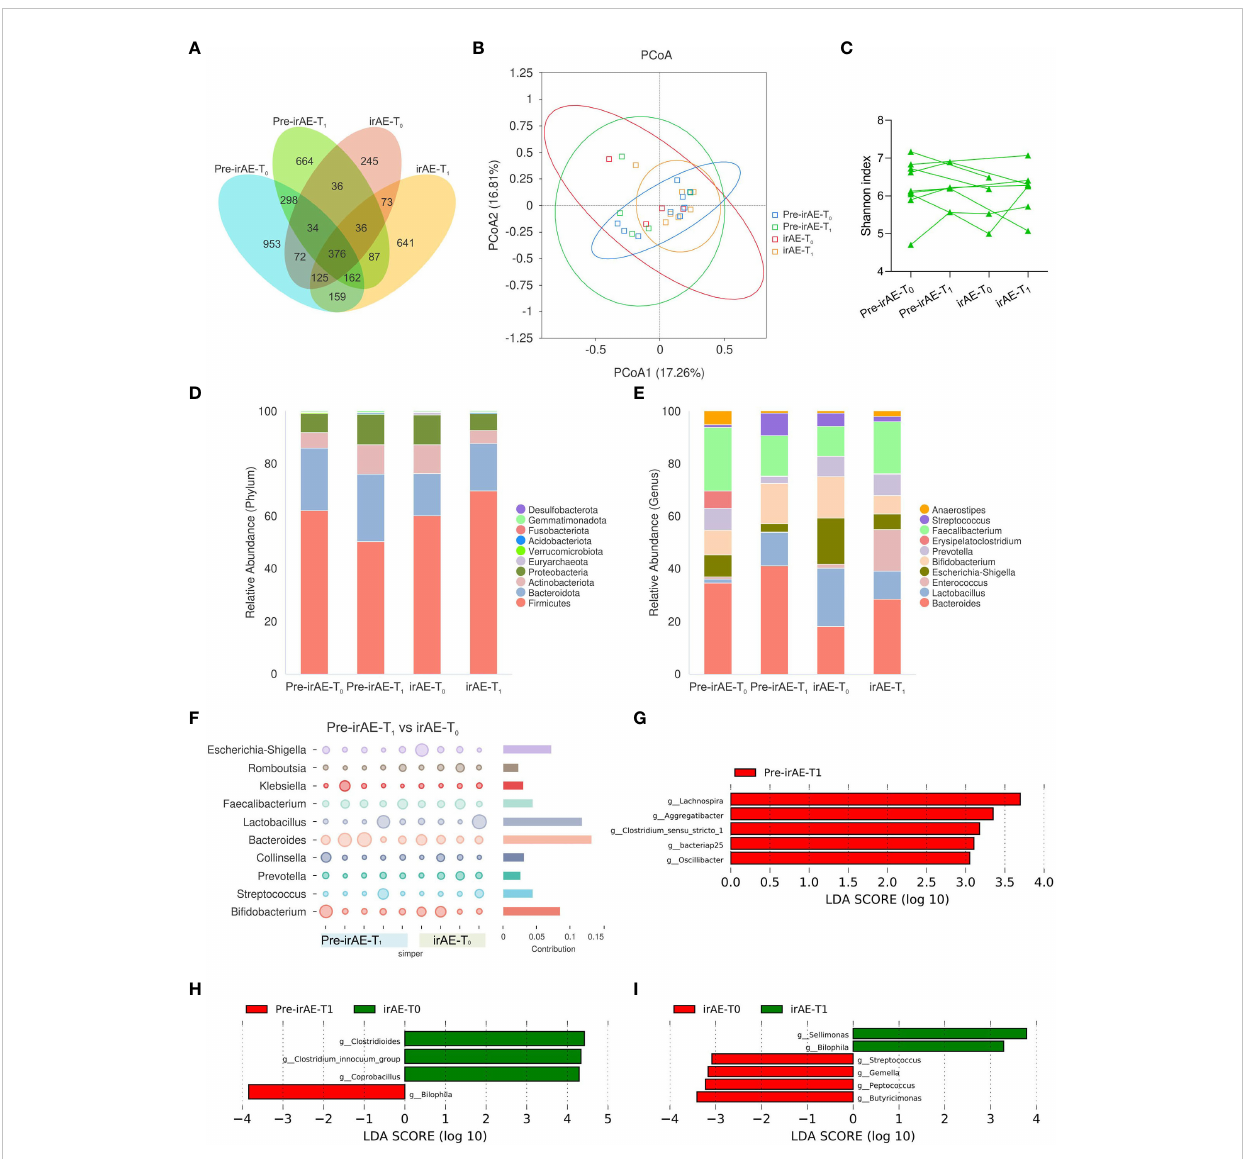
FIGURE 6 Longitudinal intestinal microbiota pro fi les in patients with irAEs. Fecal samples were sequentially collected from baseline Pre-irAE-T 0 to Pre-irAE-T 1 after ICI treatment without irAEs, irAE-T 0 with irAE occurrence, and irAE-T 1 with irAE remission. (A) Venn diagram of ASVs; (B) PCoA plot using Bray- Curtis distances; (C) Individual a -diversity by Shannon index; (D) Histogram of intestinal microbiota relative abundance with top 10 phyla; (E) Histogram of intestinal microbiota relative abundance with top 10 genera; (F) SIMPER analysis at genus level between Pre-irAE-T 1 and irAE-T 0 . LEfSe analysis (G) between Pre-irAE-T 0 and Pre-irAE-T 1 , (H) between Pre-irAE-T 1 and irAE-T 0 ; (I) between irAE-T 0 and irAE-T 1 at the genus level with threshold LDA score of 3. ASVs, amplicon sequence variants; irAE, immune-related adverse event; irAE-T 0 , irAE patients - after irAE occurrence; irAE-T 1 , irAE patients - after irAE remission; LEfSe, linear discriminant analysis effect size; PCoA, principal coordinates analysis; Pre-irAE-T 0 , irAE patients - baseline before ICIs treatment; Pre-irAE-T 1 , irAE patients - after ICI treatment without irAE occurrence; SIMPER, similarity